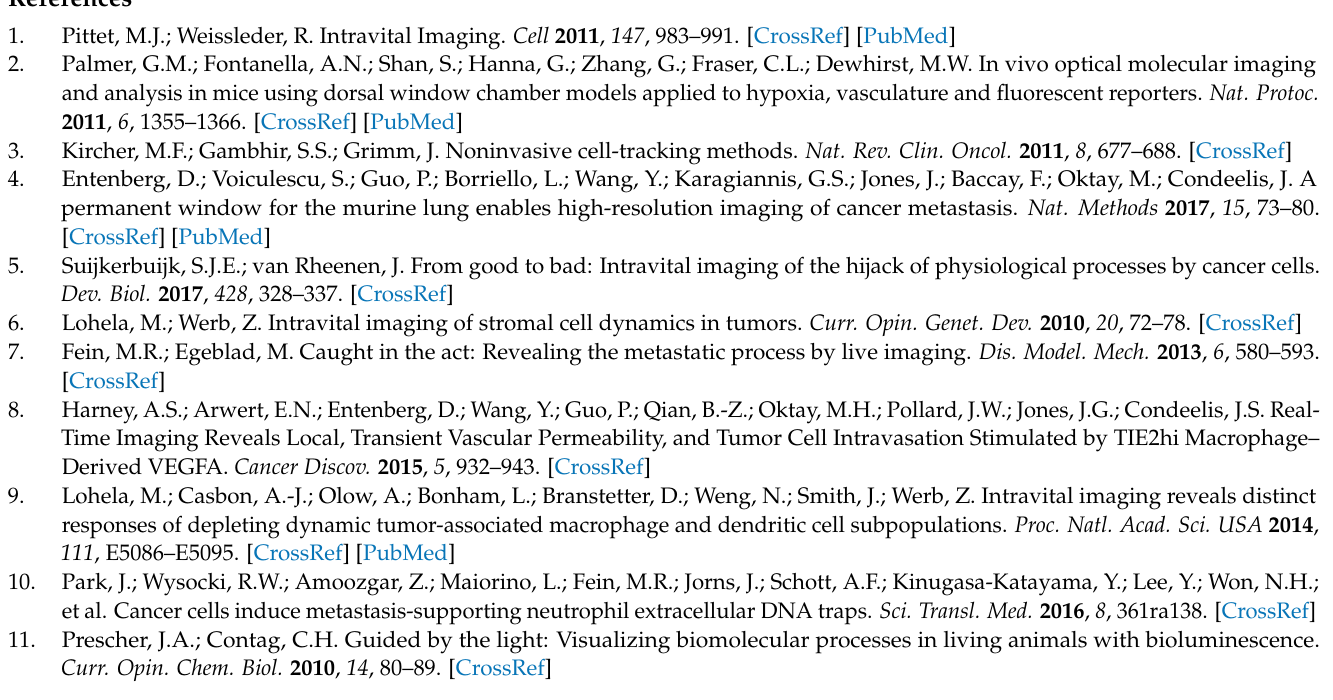
Figure S3. B16F10 Dendra2 photoconversion in skin window chamber-bearing animals. Figure S4. Intravital microscopy of abdominal window chamber